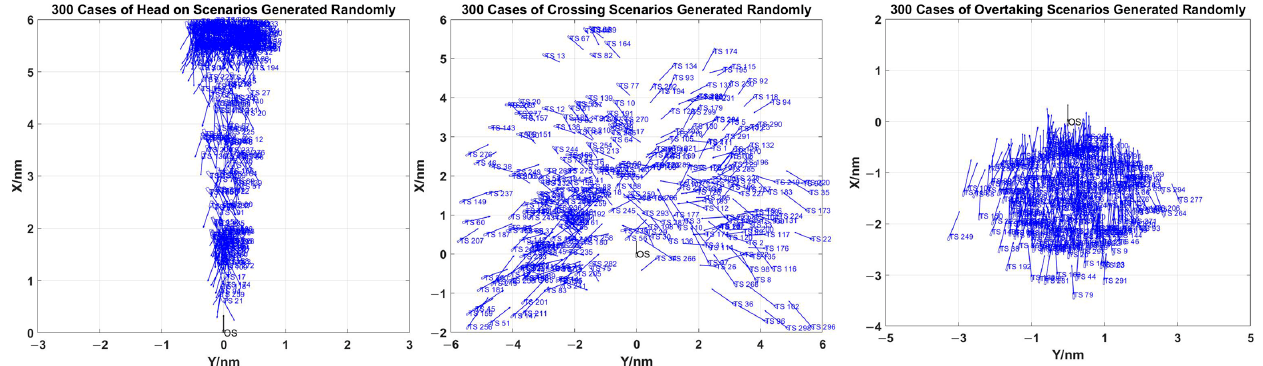
Figure 11. The 900 cases of scenarios randomly generated according to AIS possibility distributions in Section 4.2, these encounters will be tested on a collision avoidance algorithm one by one, the relative distance and relative speed distributions of these simulated scenarios are shown in the following Figures 12 and 13.